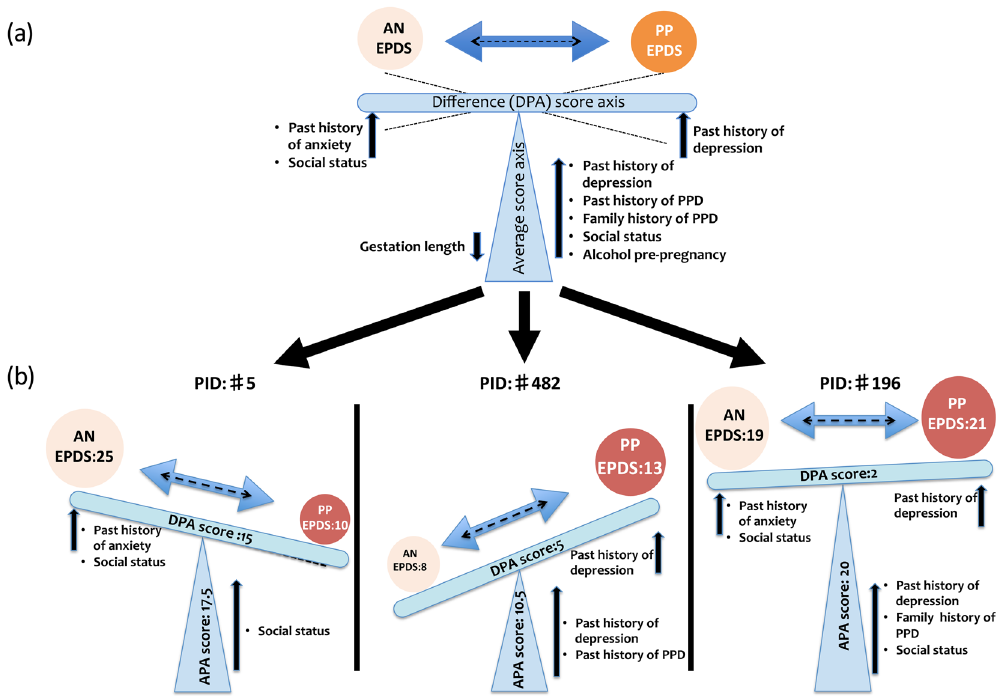
Figure 3. ( a ) A schematic of the relationship between contribution of covariates identified by a linear model to the differences and averages of postpartum and antenatal EPDS scores. The ‘average’ EDPS score at T1 and T2 time points (APA score) can be seen as an indication of overall perinatal depression not specific to either an antenatal or postpartum time point. The ‘difference’ in EPDS scores (DPA score) corresponds to shifts in EPDS score from the antenatal to the postpartum time point indicative of improvement or worsening. ( b ) Representative case studies of cohort patients with covariates that shift DPA and APA scores. Subject #5 who had two covariates with negative coefficients, a ‘previous history of anxiety’ and a ‘social status of student/unemployed’, exhibited a significant drop in the DPA score. Subject #482 had a covariate with positive coefficient, a ‘previous history of depression’ and exhibited an increase in the DPA score. In this patient, the covariates ‘past history of PPD’ as well as ‘past history of depression’ might contribute to the APA score. Subject #196 had covariates with both negative and positive coefficients, a previous history of anxiety’ and ‘previous history of depression’ and exhibited a small increase in the DPA score. In this patient, the APA score was also influenced by at least 3 covariates with positive coefficients, such as ‘family history of PPD’, ‘past history of depression’ and ‘social status’.